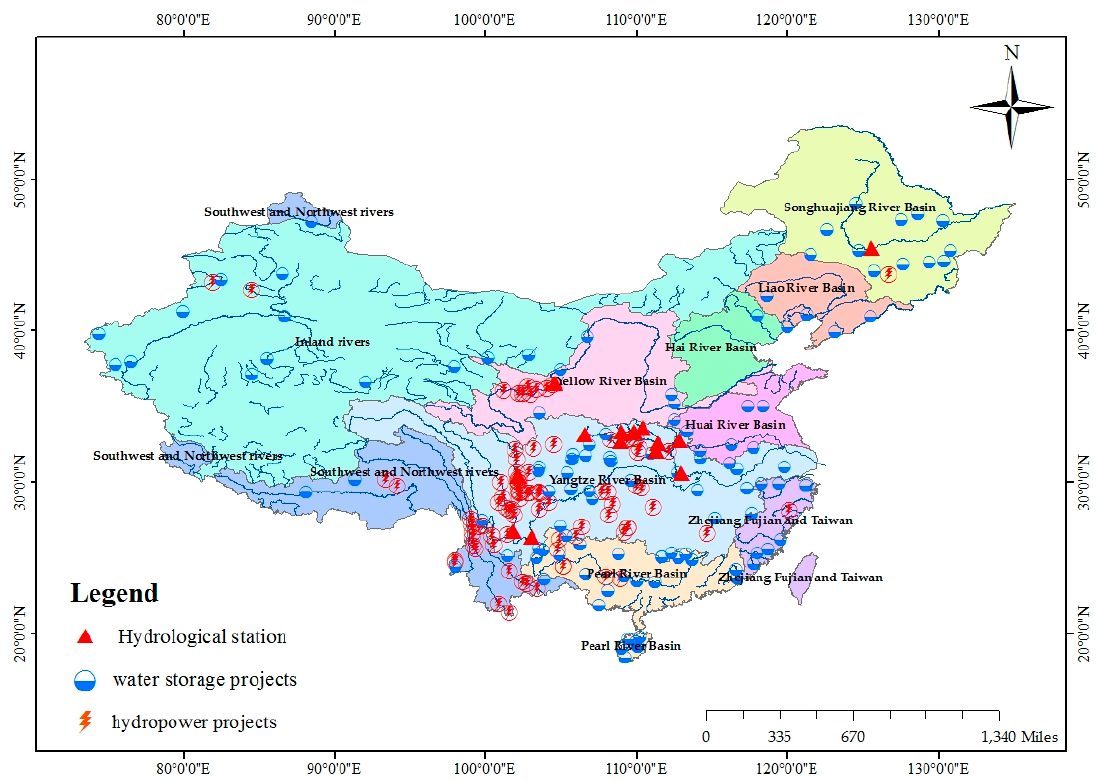
Figure 1. Distribution of water storage and hydropower projects, and hydrological stations of this study in China.